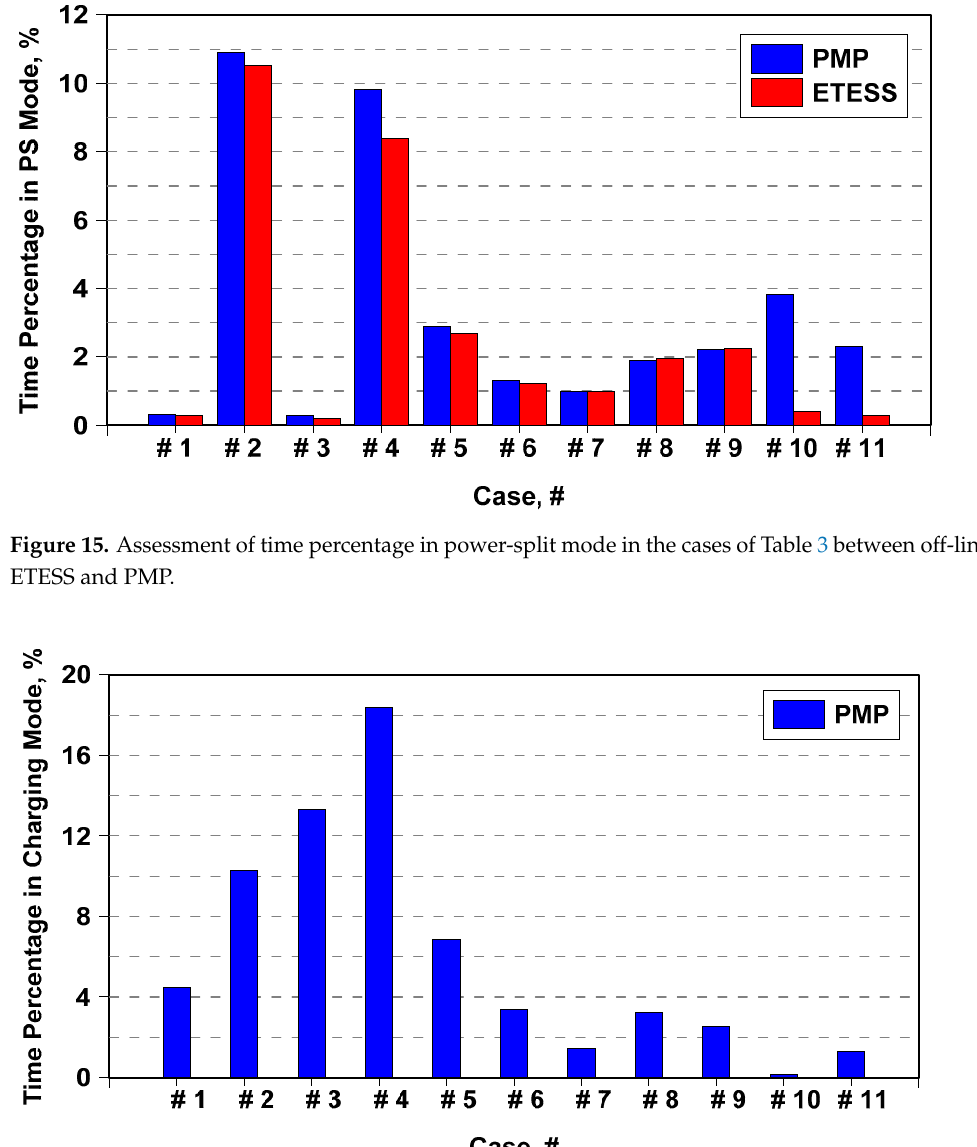
20 of 26 Figure 14. Assessment of kilometric consumed fuel and normalized simulation time in case #1 of Table 3, between off-line PMP, for different map grid discretization, and ETESS. Coming back to the comparison between the considered cases of Table 3, the bar chart in Figure 15 depicts the duration when a hybrid thermal/electric driving is chosen (PS greater than 0 and lower than 1) normalized by the total cycle duration. It can be noted that from cases #1 to #9, characterized by a more efficient ICE, a power-split is applied both from PMP and ETESS with a comparable extent. The time in PS becomes relevant